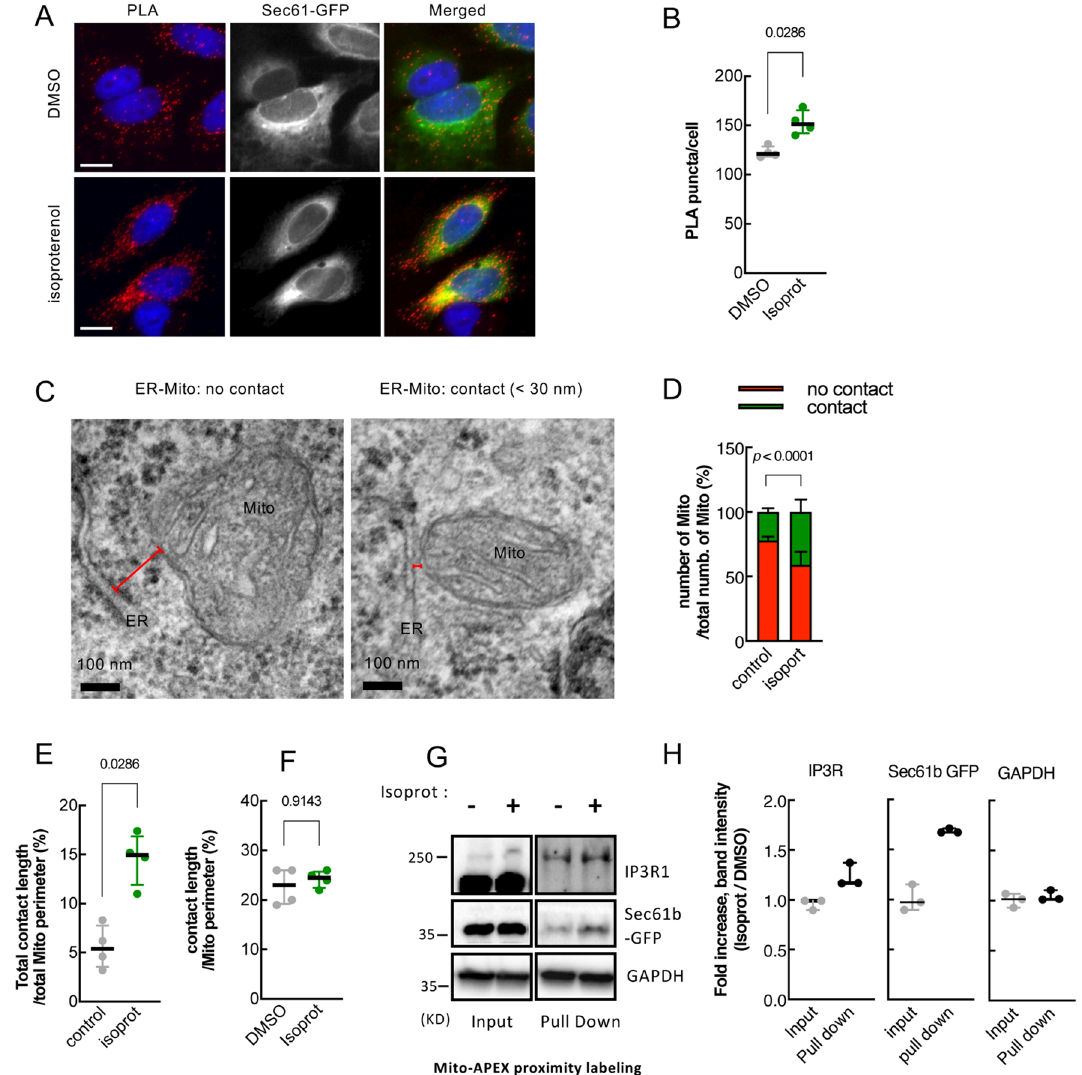
Figure 2. β2-AR agonists enhance physical contacts between ER and Mito. ( A ) Representative images of PLA in HeLa cells treated with DMSO or isoproterenol (1 μM). PLA signal (red) indicates a close contact between ER and Mito. Sec61-GFP (green): to label ER; DAPI (blue): nucleus. ( B ) Quantifications of PLA signal as shown in A ( n = 4 experiments with 77–97 cells each; Mann–Whitney test). ( C ) Representative TEM images of Mito (HEK293T cells) showing no contact (left) or a close contact (right) with ER membrane. Red lines: the distance between ER and Mito membrane. ( D ) Quantitative analysis of the percentage of the number of Mito showing contact or no contact with ER ( n = 3 experiments with 346, 405 Mito for control, isoprot; Chi- square test). ( E , F ) The percent of total contact length divided by the total Mito perimeter measured among all mitochondria ( E ) ( n = 4 experiments with 122, 171 mitochondria for control, isoprot; Mann Whitney test), and the percent of contact length divided by Mito perimeter using only Mito showing a close contact with ER ( F ) ( n = 4 experiments with 27, 95 mitochondria for control, isoprot; Mann Whitney test) in TEM images. ( G ) Representative images of Western blots of biotinylated proteins proximity-labeled by Mito-APEX (for 3 min) followed by streptavidin affinity pull down, in control- vs isoprot-treated HEK293T cells. GAPDH used for control. Full-length blots are presented in Supplementary Fig. S6. ( H ) Quantification of Immunoblots. Data in ( B,E,F,H ): median with interquartile range; Data in D : mean ± SD. Numbers at the top of each graph (here and in all other figures): p values (if ≤ 0.05, significant). Scale bars: 10 μm ( A ), 100 nm ( C